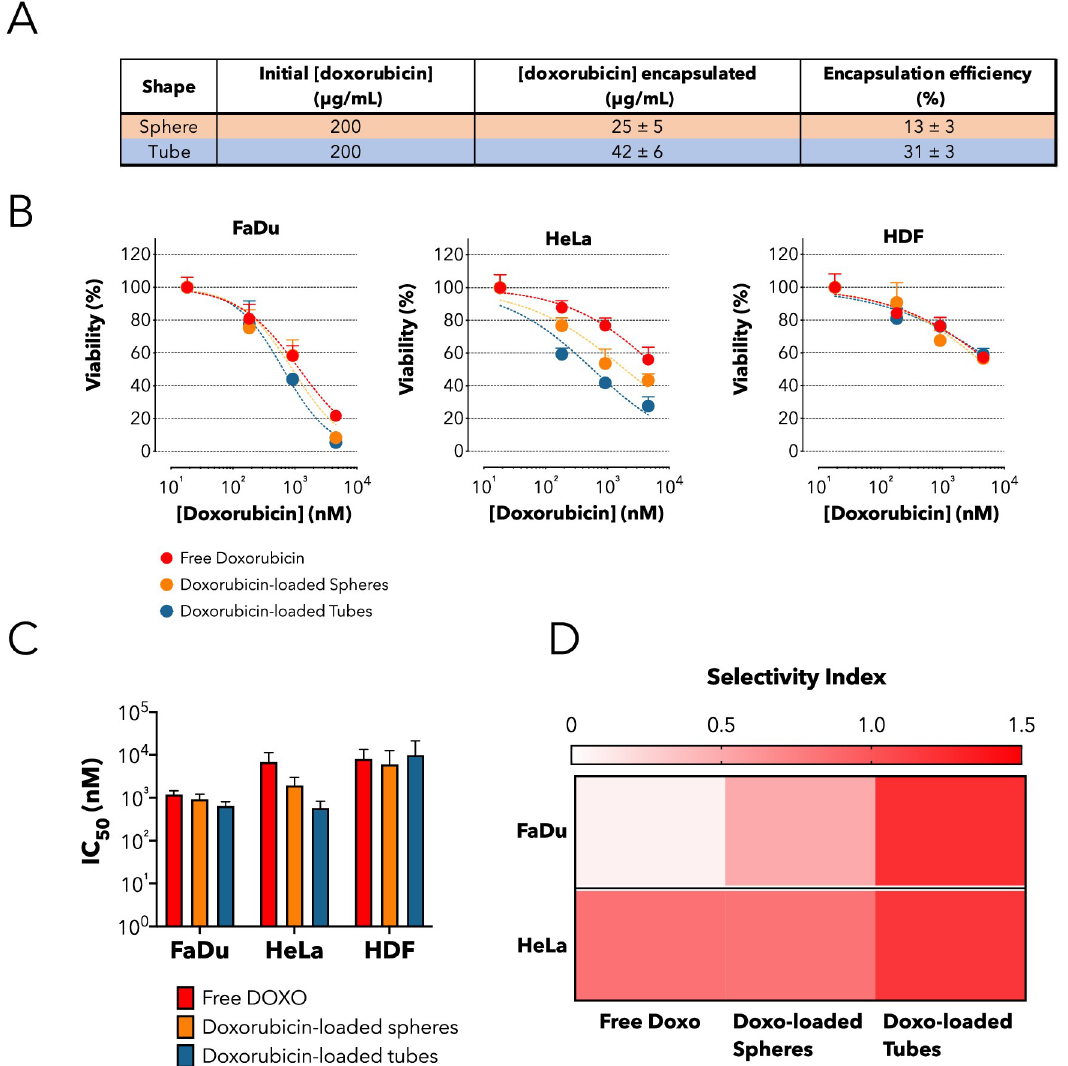
Fig 5. Enhanced cytotoxic activity of doxorubicin-loaded tubes. (A) Table summarizing the initial mass of doxorubicin solubilized with the block co-polymer, the final concentration encapsulated as measured by HPLC and the overall efficiency of encapsulation. (B) Cell viability test on HDF, HeLa and FaDu cells following 48 hours incubation with increasing extracellular concentrations of either free doxorubicin or doxorubicin loaded in spheres or tubes. (C) IC50 values (nM) for the free (green), spheres-encapsulated (orange) and tubes-encapsulated (blue) DOXO. (D) Heat-map showing the selectivity index (SI) of free doxorubicin, doxorubicin-loaded spheres, or doxorubicin-loaded tubes towards FaDu or HeLa cells. Note that SI is the log ratio between the IC50 in non-cancer and in cancer cells (HDF as